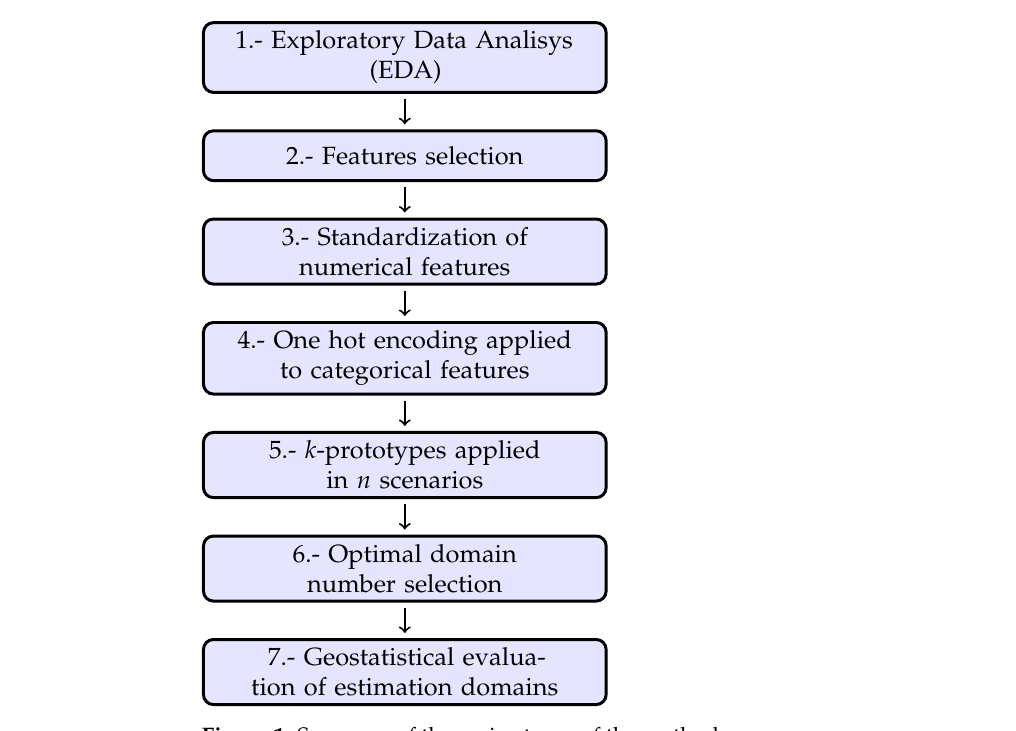
Figure 1. Sequence of the main stages of the method. Algorithm 1 Algorithm to determine the number of clusters